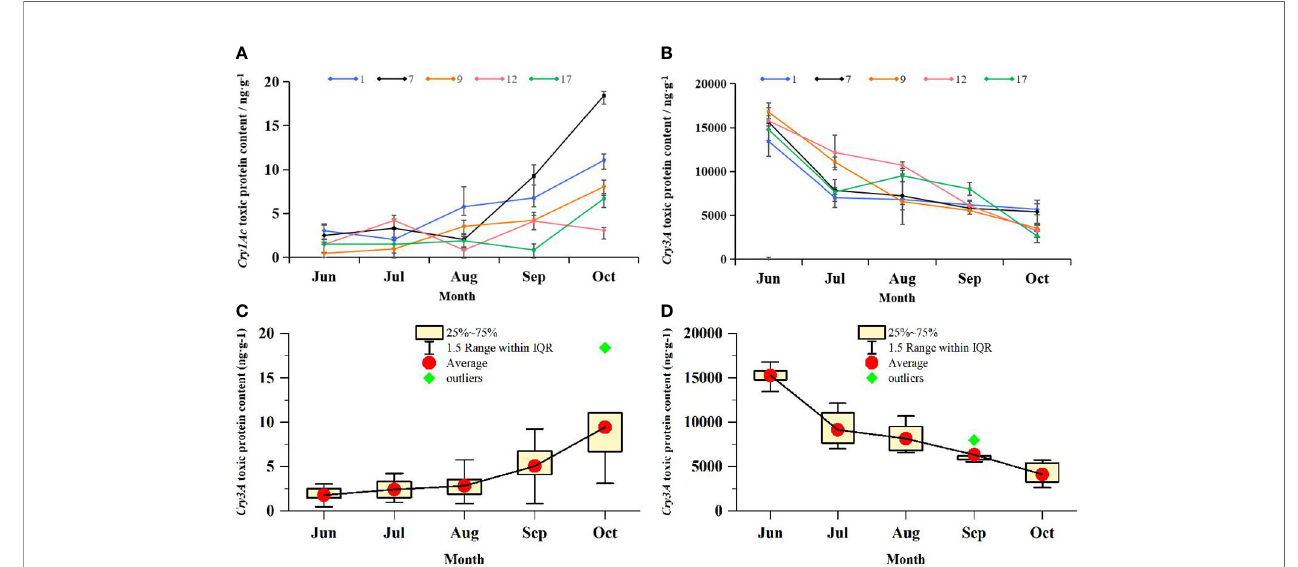
FIGURE 5 | Changes in the content of Cry1Ac and Cry3A protein toxins in transgenic lines over time. ELISA was used to determine the content of toxic protein in transgenic lines. (A) Seasonal variation of toxin-protein Cry1Ac content. Data are from the mean values of Cry1Ac toxic protein content in 3 leaves of each transgenic line, three plants were selected for each transgenic line, and one leaf was selected for each plant. (B) Seasonal variation of toxin-protein Cry3A content. Data are from the mean values of Cry3A toxic protein content in 3 leaves of each transgenic line, three plants were selected for each transgenic line, and one leaf was selected for each plant. 1, 7, 9, 12, and 17 respectively represent transgenic lines. Line chart shows the change trend of virulence proteins in each line from June to October. Error bars represent the standard deviation of the mean. (C) Box plot of seasonal variation of Cry1Ac toxic protein content; Data are from Cry1Ac toxic protein content in all transgenic lines. (D) Box plot of seasonal variation of Cry3A toxic protein content; Data are from Cry3A toxic protein content in all transgenic